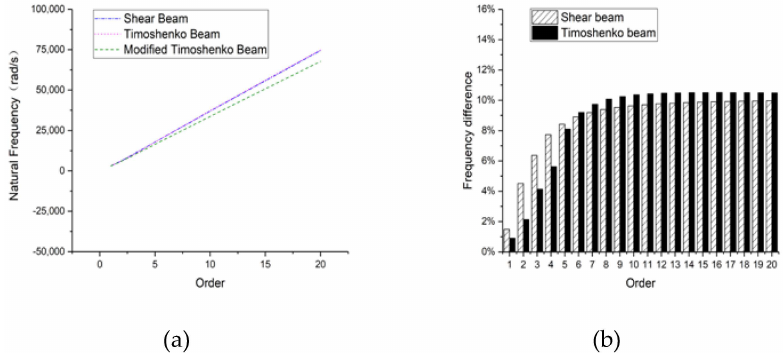
Figure 18. Natural frequencies of the 2-m-long beam: ( a ) overall frequency curve and ( b ) frequency di ff erence compared with a modified Timoshenko